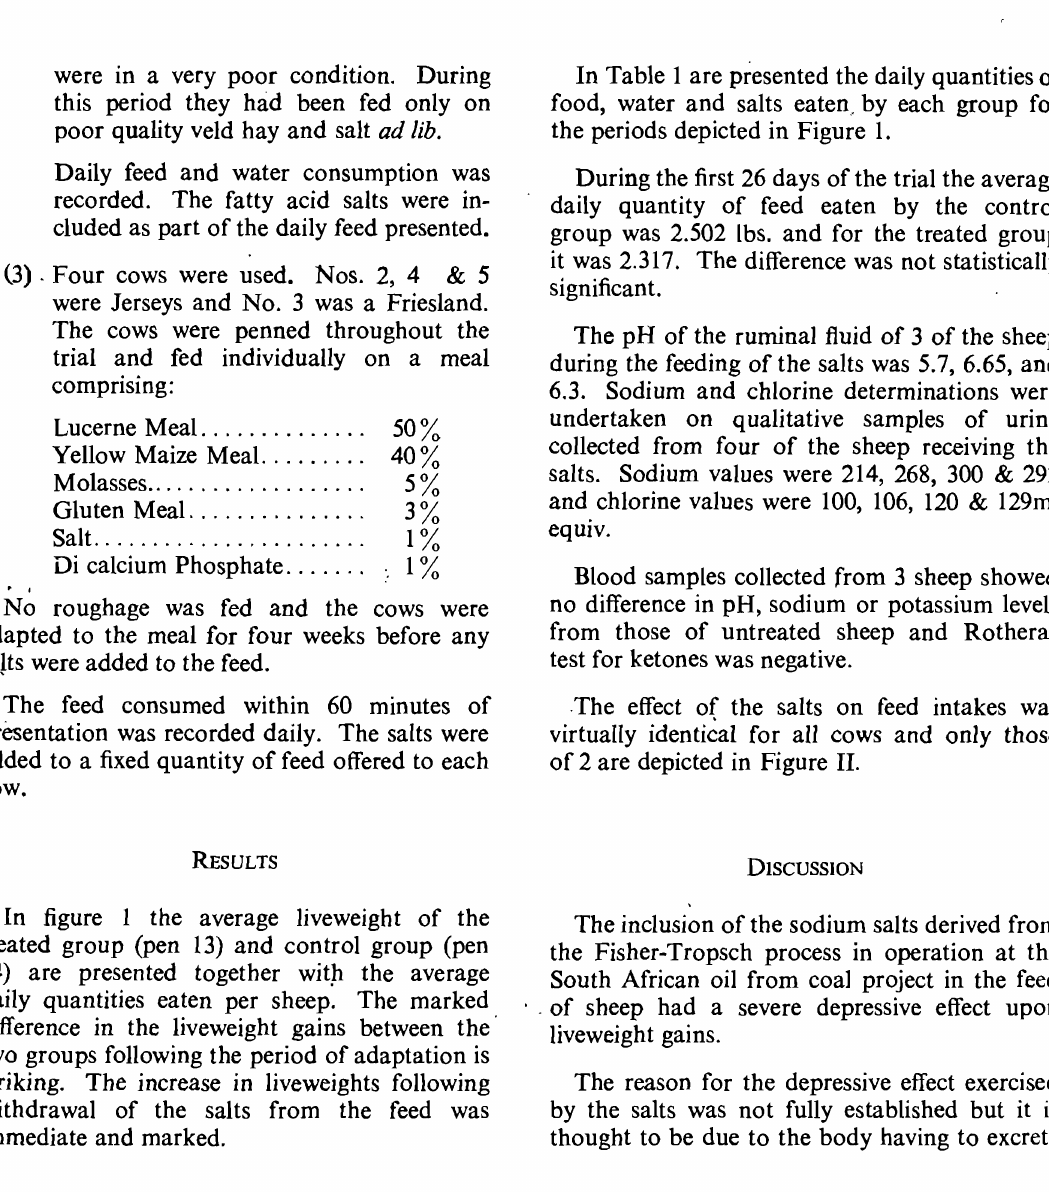
TABLE I.-AVERAGE QUANTITY OF FEED, FATTY ACID SALTS AND WATER CONSUMED PER DAY PER PEN OF 5 SHEEP FOR THE PERIODS DEPICETD IN FIGURE 1.